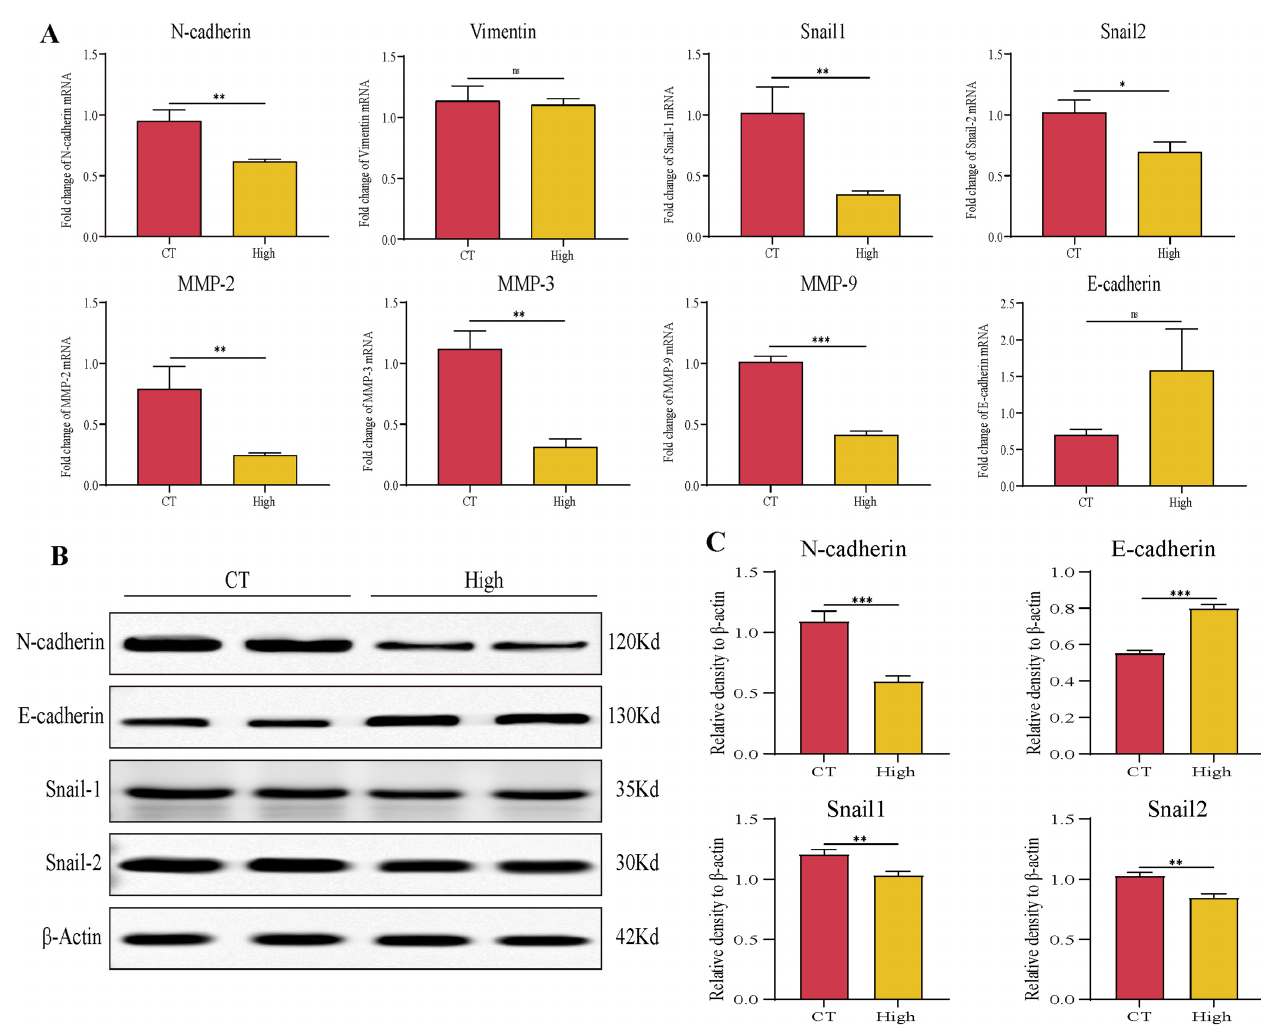
Figure 8. TAX inhibits the EMT in vivo: ( A ) The expression of several key EMT regulators was detected using RT-qPCR after the treatment of TAX in tumor tissue of tumor-bearing mice. ( B , C ) The expression of several key EMT regulators was detected using western blotting after the treatment of TAX in tumor tissue of tumor-bearing mice. Images were quantified and statistically analyzed. ns, not significant, * p < 0.05, ** p < 0.01, *** p < 0.001. (Student’s t -test). Data are presented as mean ±